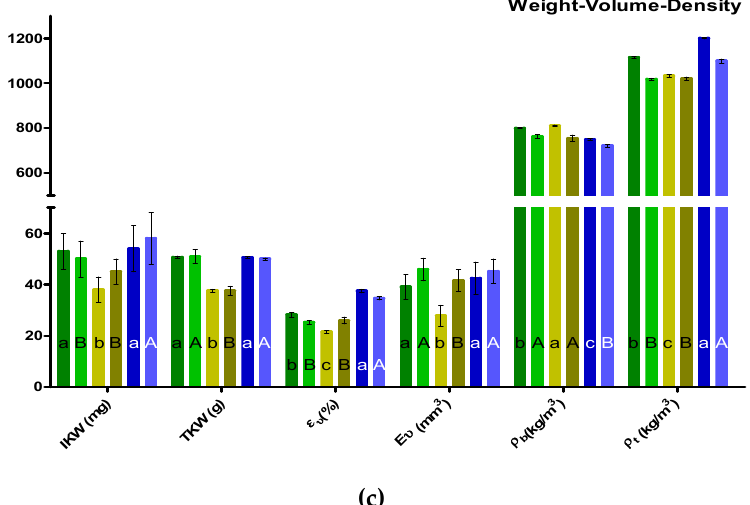
Figure 1. Mean ± standard deviation for the appearance ( a ), geometric ( b ), and weight/volume/density properties ( c ) of the three cereal types at two moisture contents (12% and 16%). R LW : length/width ratio; IKW : individual kernel weight; TKW : thousand kernel weight; ε v : porosity in bulk; E υ : ellipsoidal volume; ρ b : apparent density; ρ t : true density. Mean values for the same cereal type with different letters (lowercase and uppercase) were statistically different ( p < 0.05) at the different moisture contents (12% and 16%,